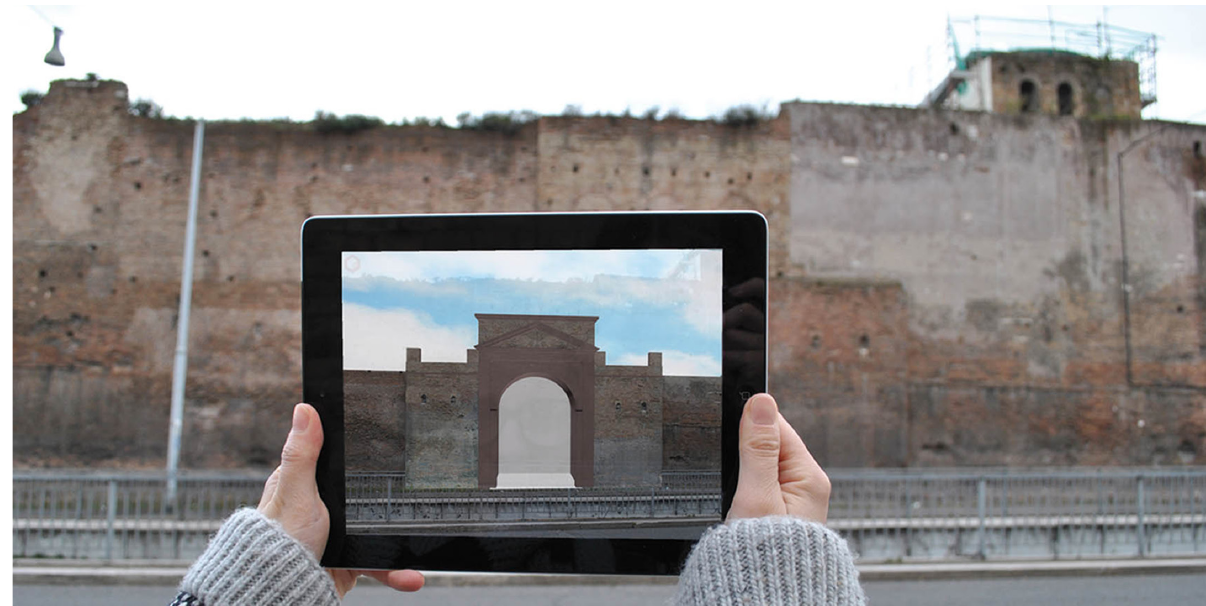
Figure 4. Augmented Reality